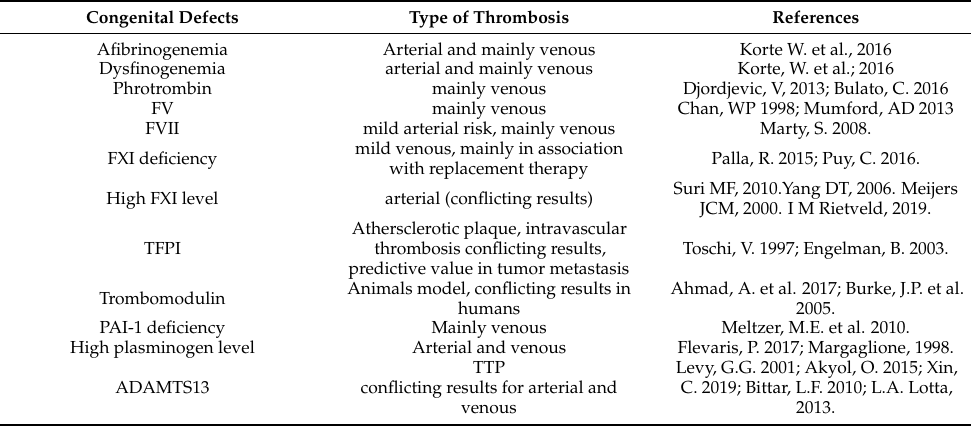
Table 1. Characteristics of thrombosis of congenital disorders